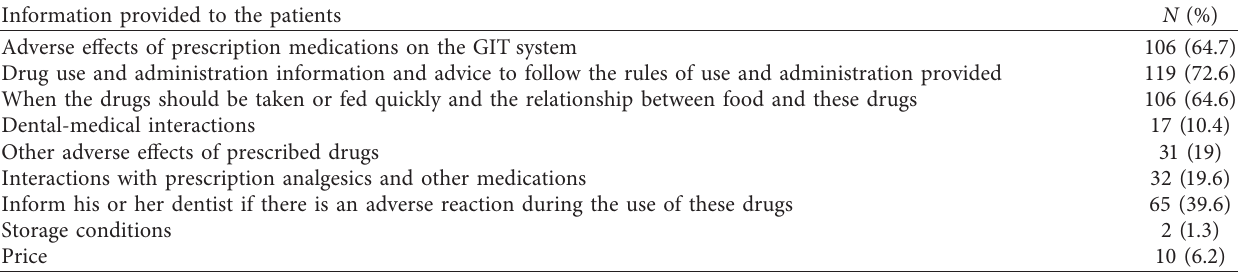
Table 4: Information given to the patients by the dentist about prescribed antibiotics and